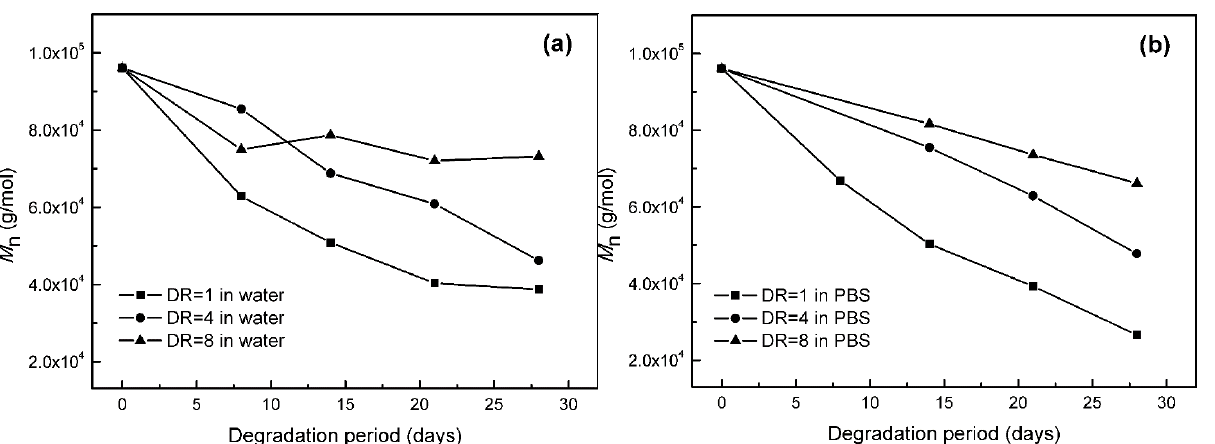
Figure 10. Residual molecular weights of PLLA as-extruded and drawn tapes before and after degradation in ( a ) water and ( b )